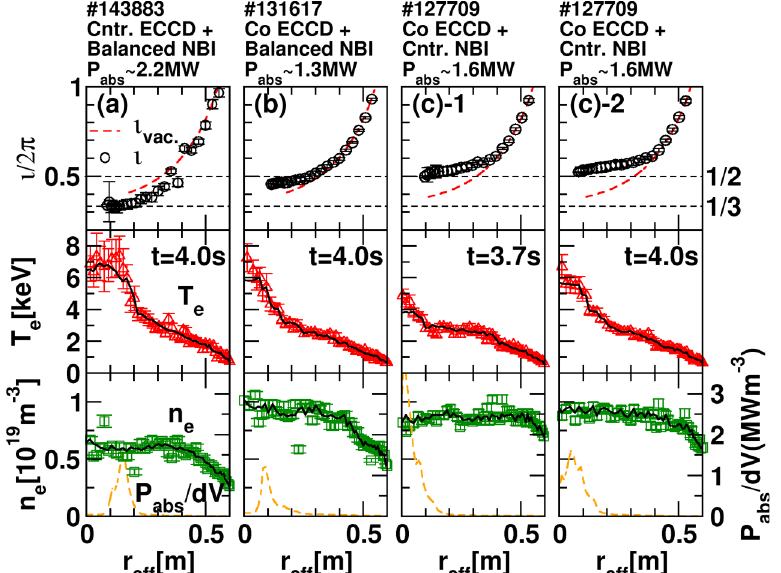
Fig.10 : Profiles of (Top) measured and vacuum i /2 p , (Middle) electron temperature, (Bottom) electron density, and power density absorbed by electrons plotted versus effective minor